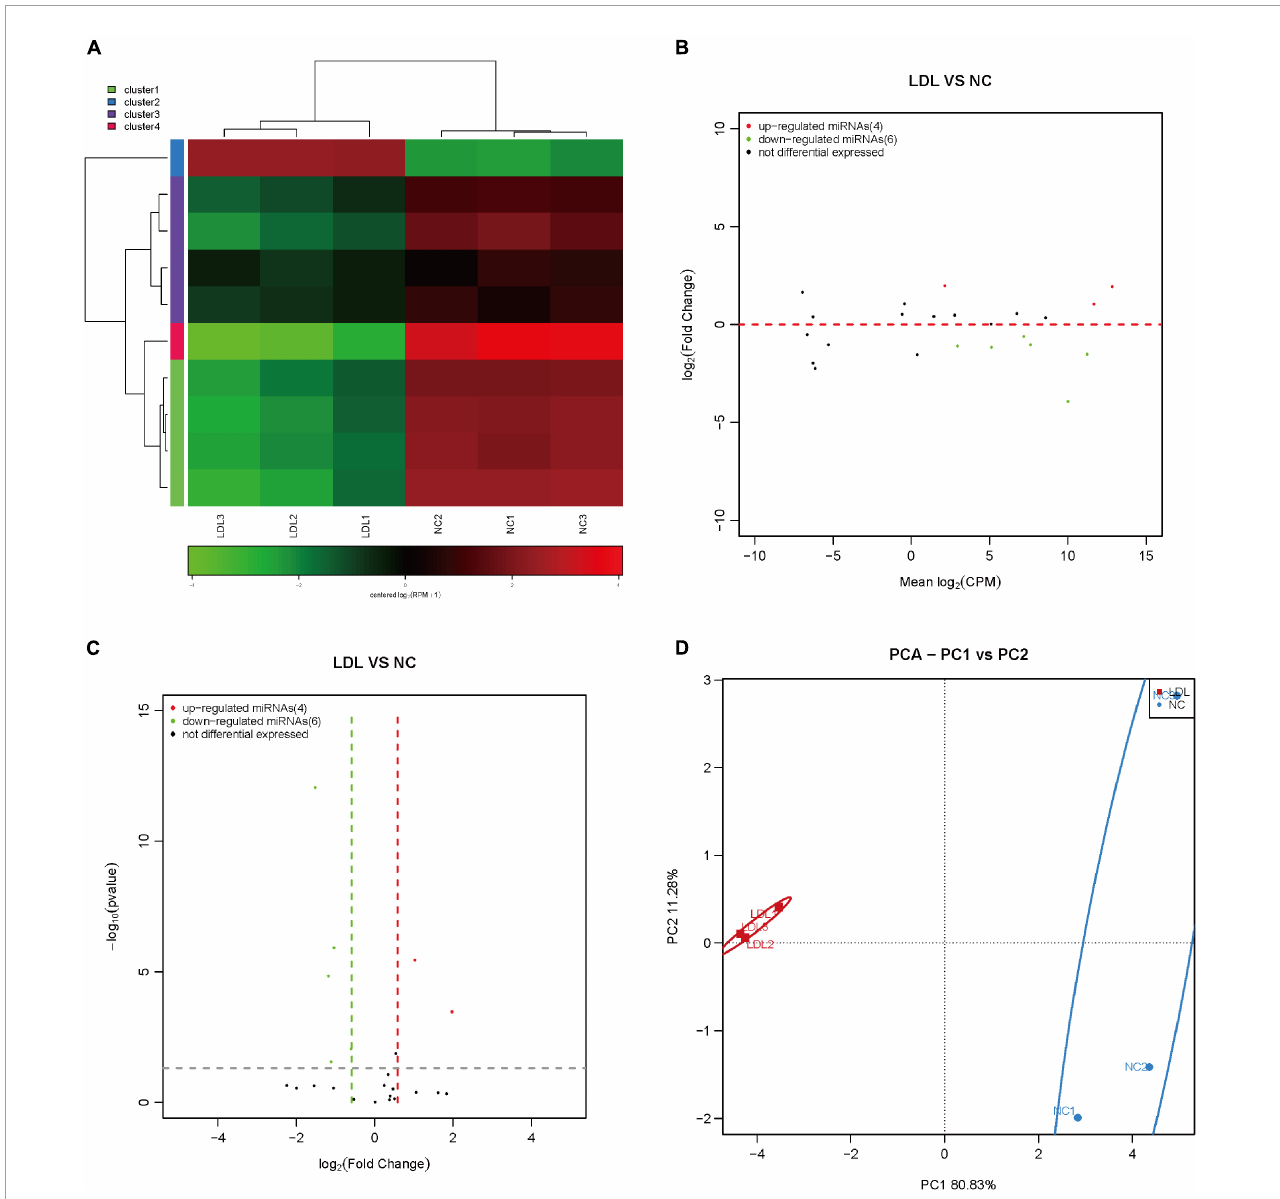
FIGURE5 Differential expression of repeat RNA in rat endothelial cells treated with ox-LDL. Heatmap (A) , MA map (B) , and volcano map (C) show the expression of repeat RNA in rat endothelial cells with ox-LDL treatment, n = 3. (D) PCA showed the expression of repeat RNA in rat endothelial cells with or without ox-LDL treatment, n =